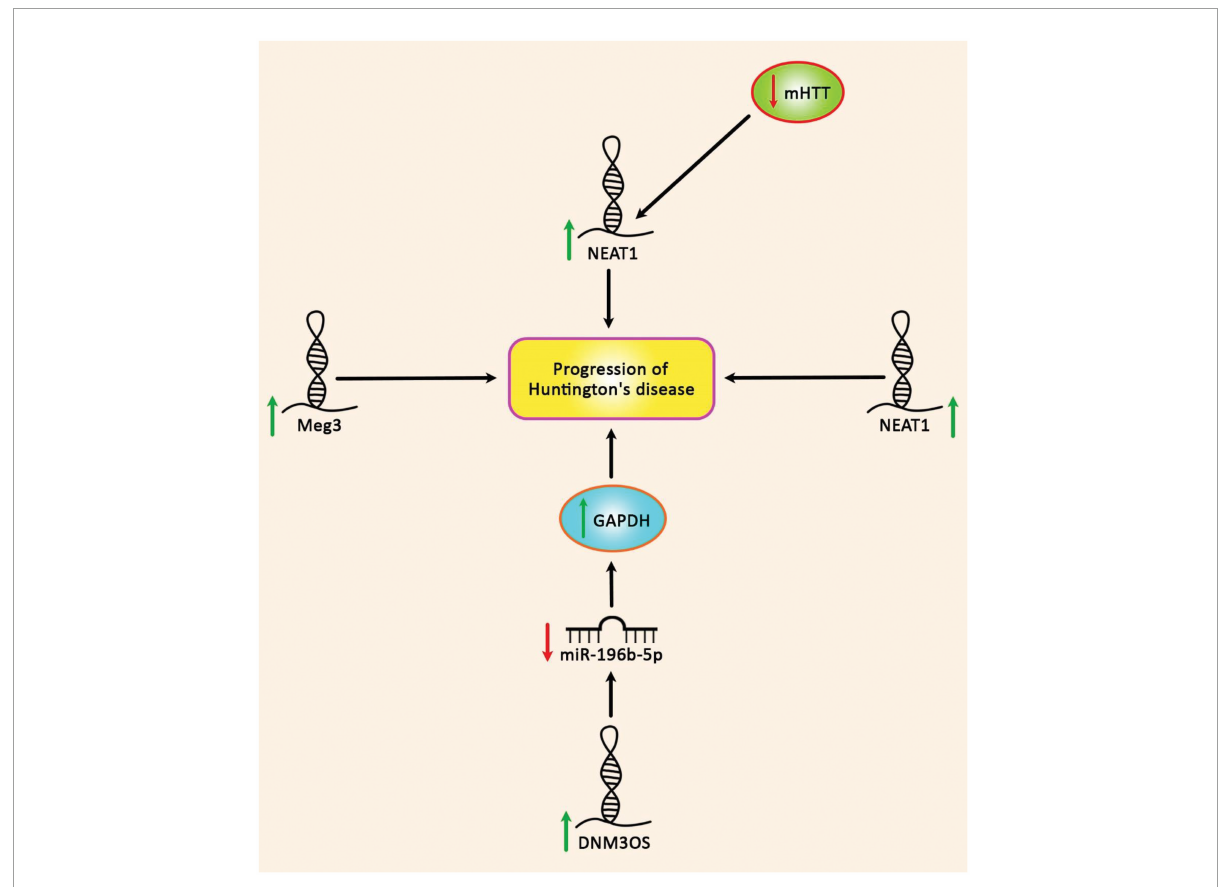
FIGURE5 Up-regulation of DNM3OS, NEAT1, and Meg3 in Huntington’s disease.